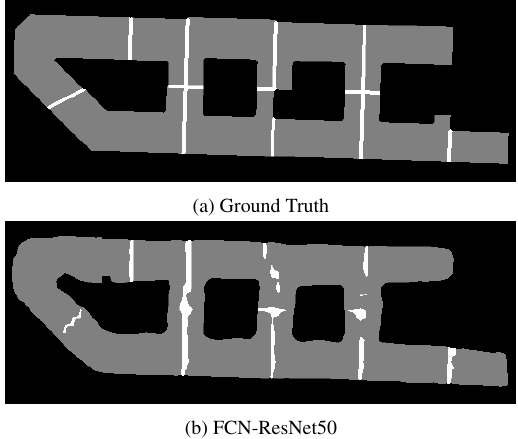
Figure 2. One building example of (a) ground truth and (b) a raw prediction output from FCN-ResNet50 with RGB